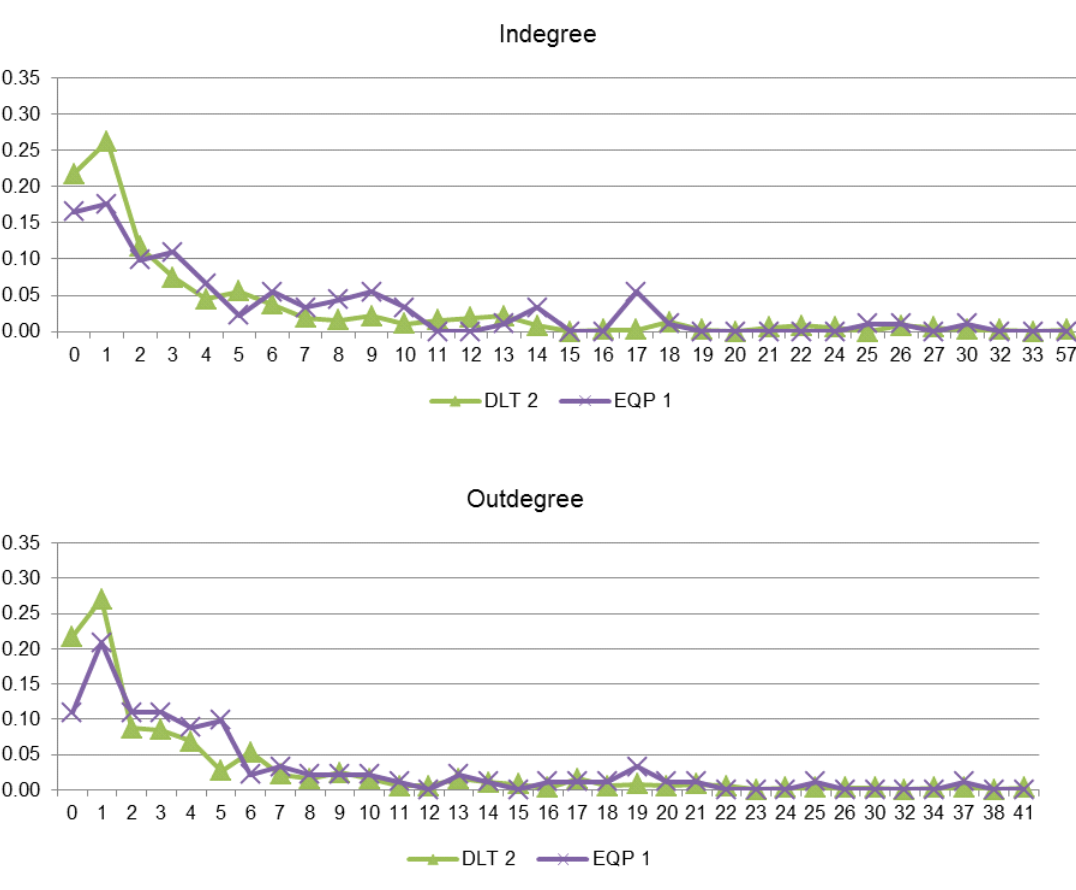
Figure 1. Proportion of outdegree